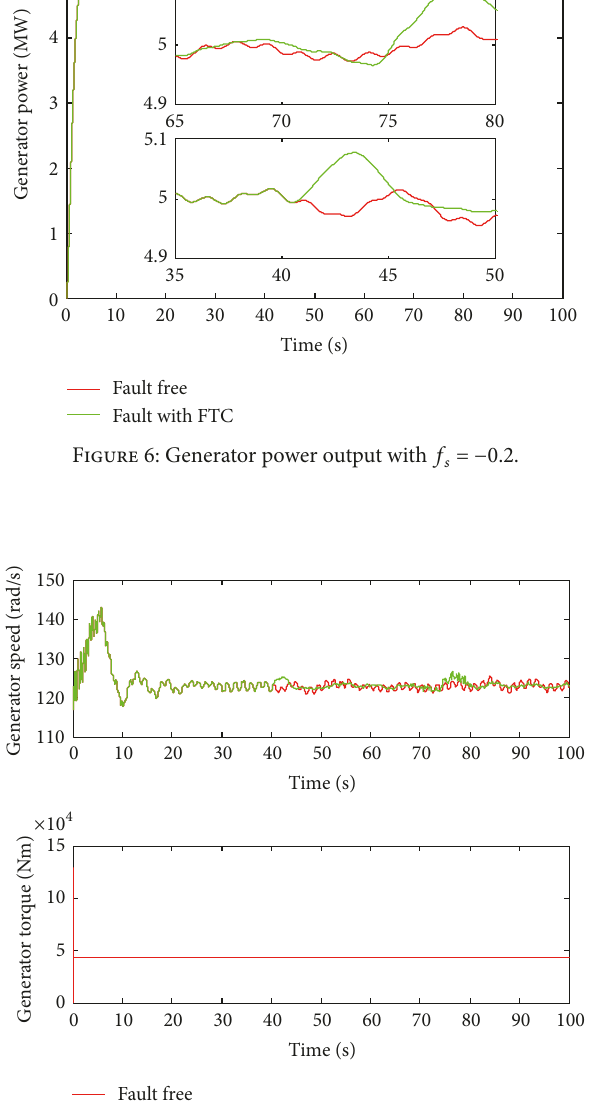
Figure 9: Generator speed and its torque with 𝑓 𝑠 = −